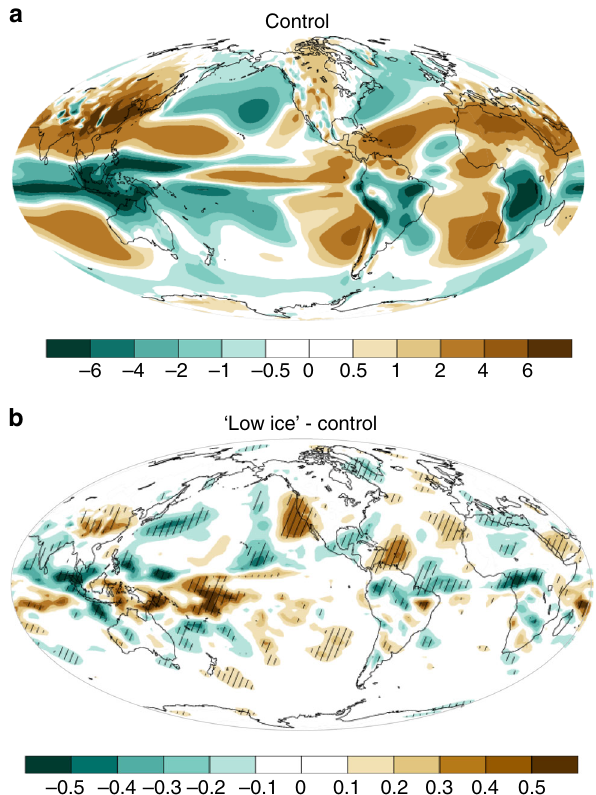
Fig. 3 Changes to 250 mb vertical velocity (hPa/s). a Control simulation climatology. b The response to Arctic sea-ice loss ( “ low Arctic ice ” minus control ensemble mean). Positive sign denotes subsidence. Stippling in b indicates anomalies that are statistically signi fi cant at the 90% con fi dence